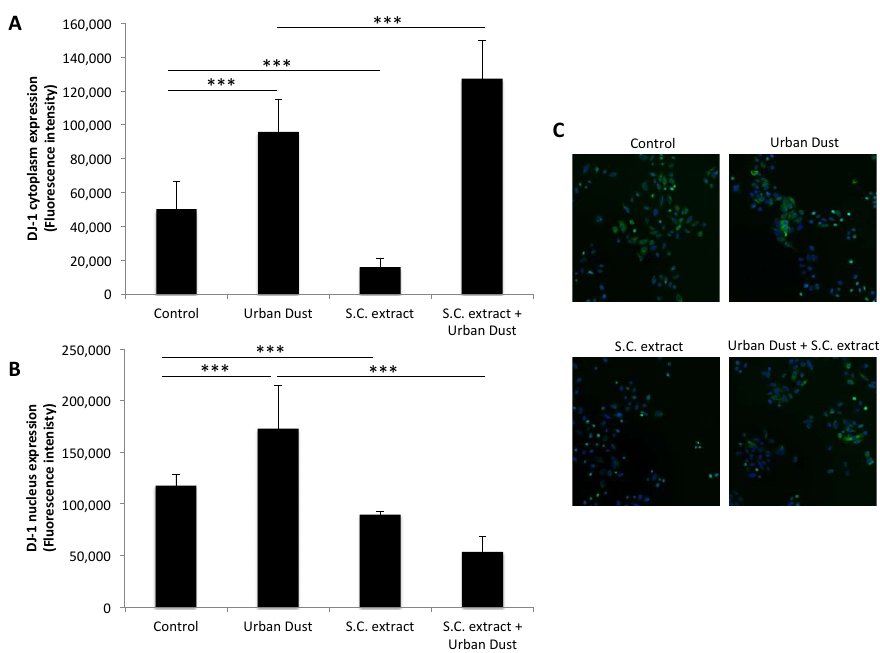
Figure 3. DJ-1 cytoplasm ( A ) and nucleus ( B ) expression in the NHEK after Urban Dust exposure, or co-treatment with Urban dust and S.C . extract (50 μg·mL −1 ). *** p < 0.001. ( C ) Representative pictures of DJ-1 expression: DJ-1 in green, Nucleus in blue. Cosmetics 2018 , 5 , x FOR PEER REVIEW